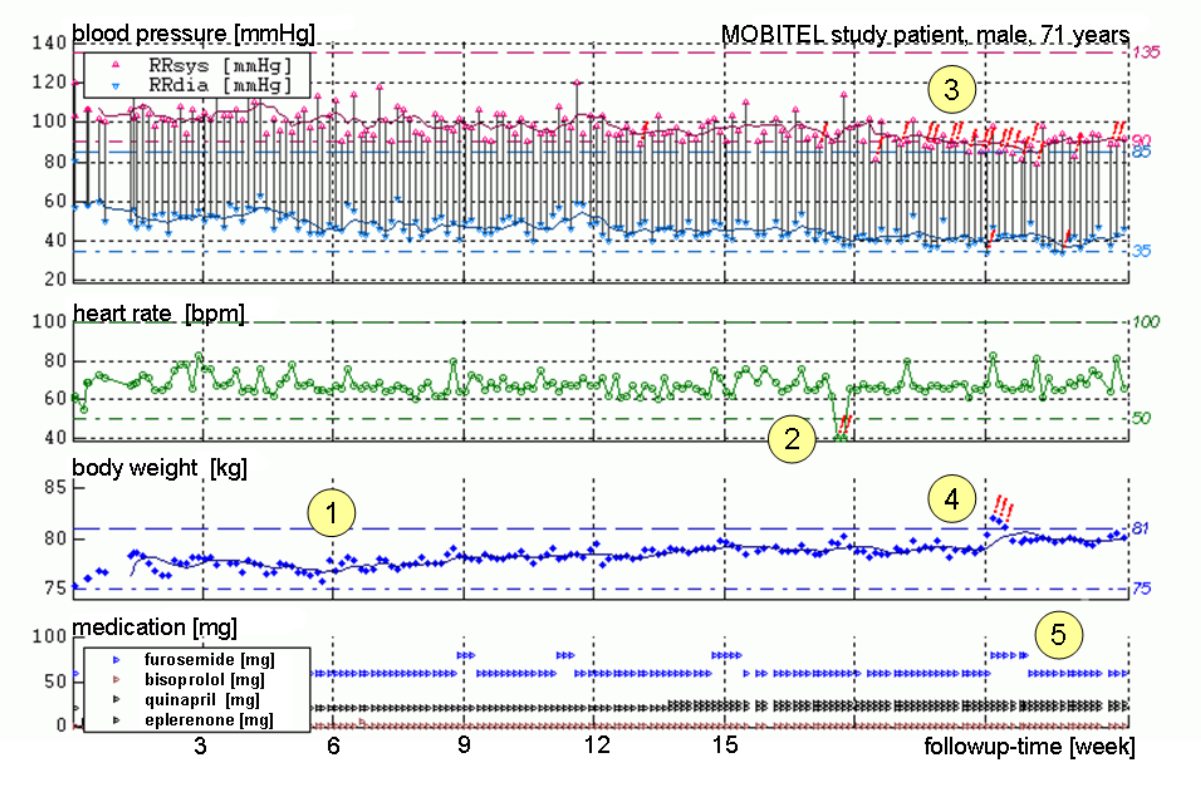
Figure 2. Trend chart of vital parameters of a typical patient (male, 71 years) over the 6-month study period: Each dot represents a transmitted value of (from top to bottom) systolic (red) and diastolic blood pressure (light blue), heart rate (green), body weight (blue), and heart failure medication (bottom panel, furosemide in blue); (1) After discharge from hospital, all transmitted values are stable, (2) Red exclamation marks indicate low heart rate, (3) Alarms due to decreased blood pressure herald a phase of instability, (4) Increase in body weight of more than 2 kg in 2 days, causing an alarm (red exclamation marks), (5) After telephone contact with the patient and confirmation of values, the daily dose of furosemide is temporarily increased and body weight returns to stable values within 3